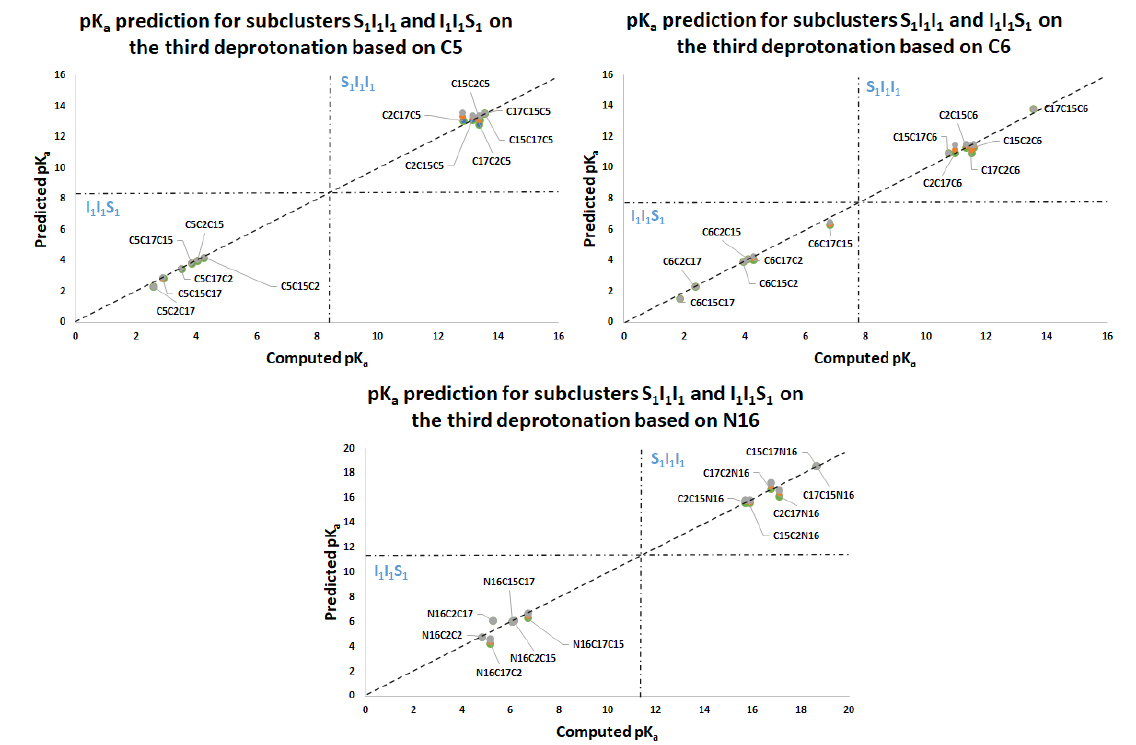
Figure 16. pK a prediction for the third deprotonation on the subclusters S 1 I 1 I 1 and I 1 I 1 S 1 based on C5, C6, and N16. Predictions are marked as gray (max), orange (mean), and green (min).